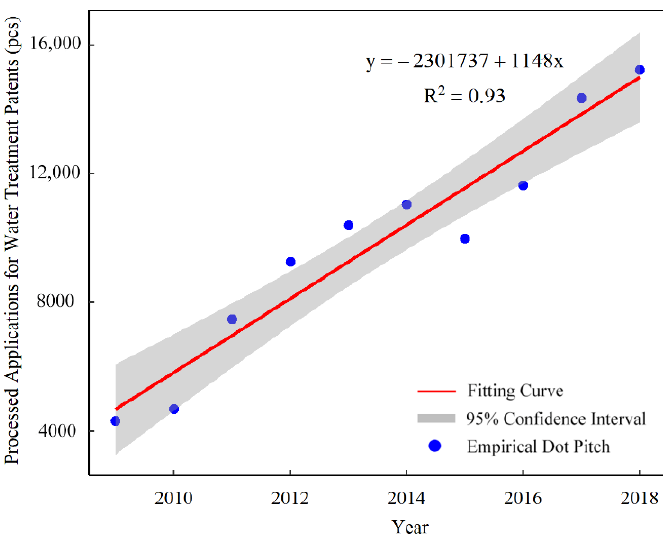
Figure 5. Investment in drainage fixed assets.